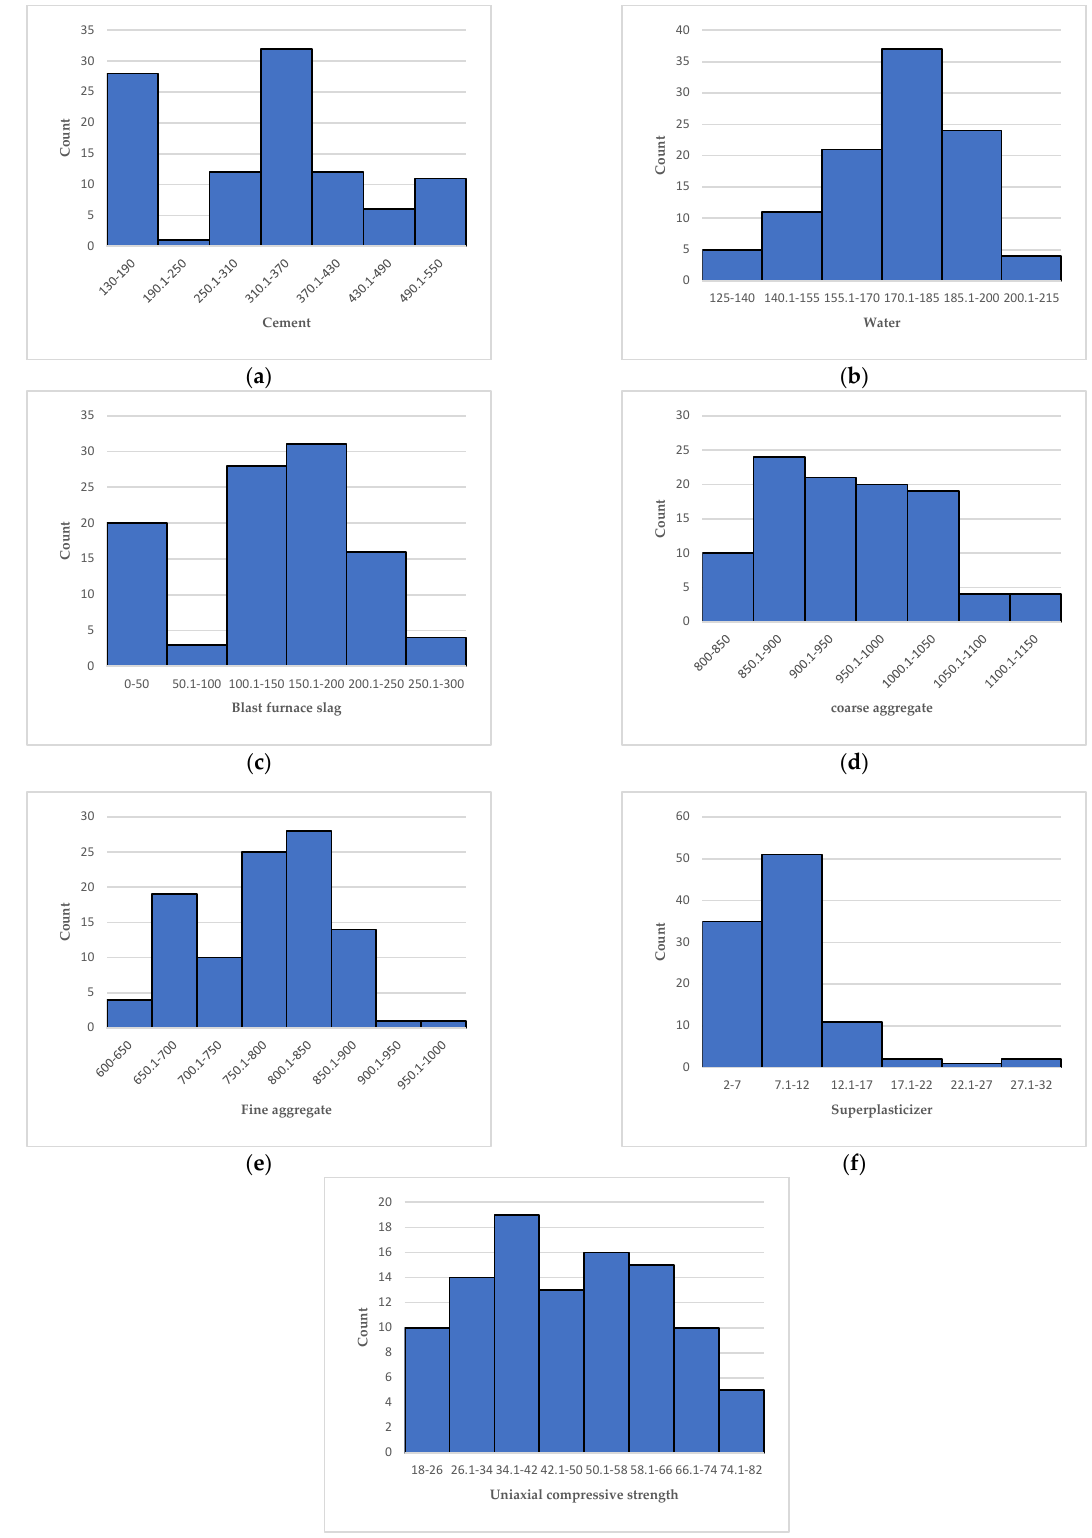
Figure 2. Frequency distribution histogram of variables. ( a ) Cement; ( b ) Water; ( c ) Blast furnace slag; ( d ) Coarse aggregate; ( e ) Fine aggregate; ( f ) Superplasticizer; ( g ) UCS.